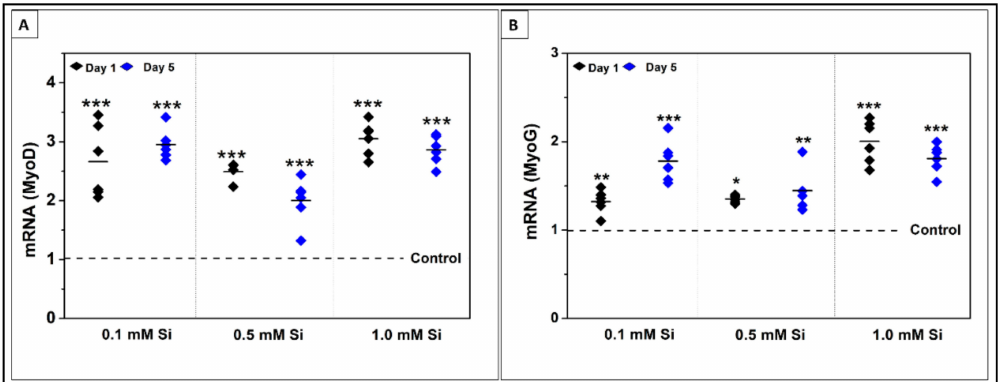
Figure 4. Myogenic determination protein (MyoD) and Myogenin (MyoG) genes expression at 1 and 5 days of C2C12 cell differentiation. ( A ) Si-ions increased the expression of MyoD at early stage of differentiation (Day 1); 0.1 and 1.0 mM of Si-ions significantly increased MyoD expression at day 1 and 5 (* p < 0.05, ** p < 0.01, *** p < 0.001). ( B ) MyoG expressed at a later stage marking the commitment to differentiation, 1.0 mM Si-ions significantly increased MyoG expression by 2-folds at day 1. By day 5, both 0.1 and 1.0 mM of Si-ions increased MyoG expression almost 2-fols compared to the